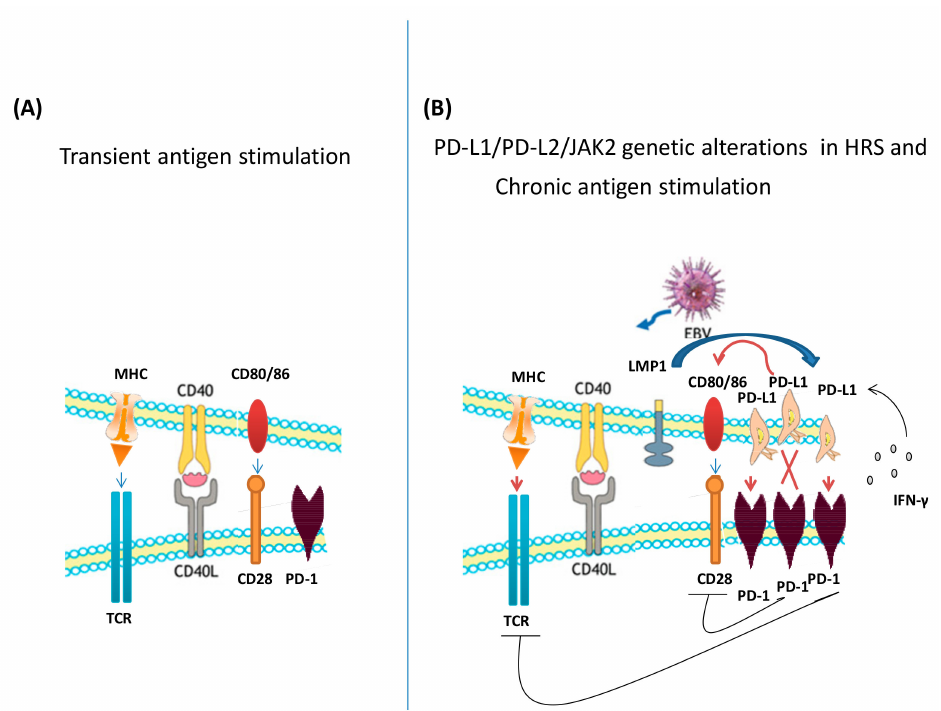
Figure 2. Programmed cell death 1 (PD-1) expression on T-cells ( A ) PD-1 expression is induced when the T-cell receptor (TCR) recognizes an antigen during di ff erentiation from a naïve cell into an e ff ector cell. In the absence of TCR signaling, PD-1 is lost, ( B ) PD-1 expression is maintained upon chronic antigen stimulation such as during chronic viral / bacterial infections and in cancer. When PD-1 binds the programmed cell death 1 ligand (PD-L1) it inhibits TCR / Major Histocompatibility Complex (MHC) and CD80 / CD28 signaling and therby inhibits T cell activation. PD-1–PD-L1 binding occurs predominantly in Hodgkin lymphoma (HL) due to frequent genetic alterations leading to up-regulation of PD-L1 / PD-L2 / Janus kinase 2 (JAK 2) signaling or to expression of the Epstein-Barr virus (EBV) latent membrane protein 1 (LMP1) protein that induces the expression of PD-L1 in the Hodgkin Reed-Sternberg (HRS) cells. PD-L1 molecules can also bind the receptor CD80, thus attenuating the signaling from PD-1–PD-L1